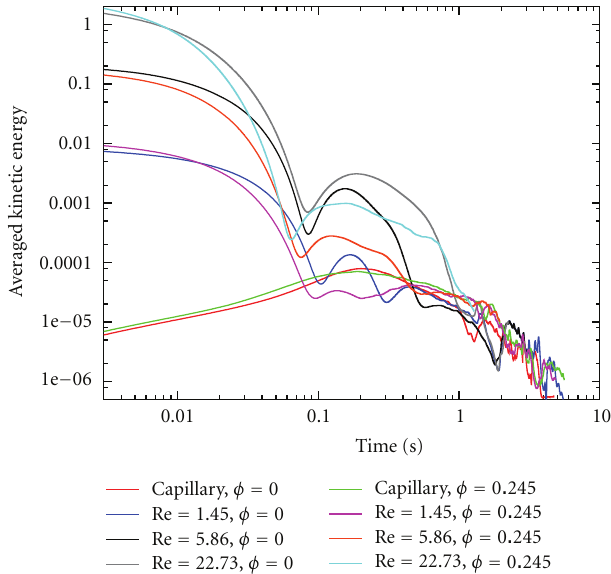
Figure 8: The averaged kinetic energy in time during spreading for various flow